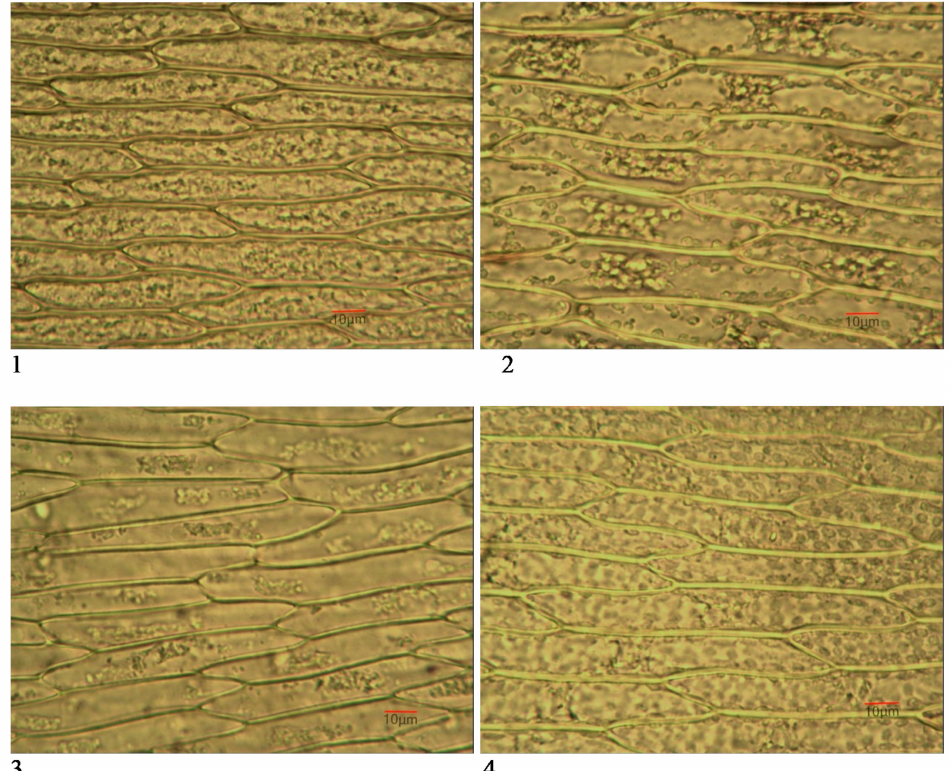
Figure 3. Photomicrographs of the leaf cells from Fontinalis antipyretica : 1 , 2 —Background (Control); 3 , 4 —Zhrebchevo Reservoir; 1 , 3 —twig leaves; 2 , 4 —stem